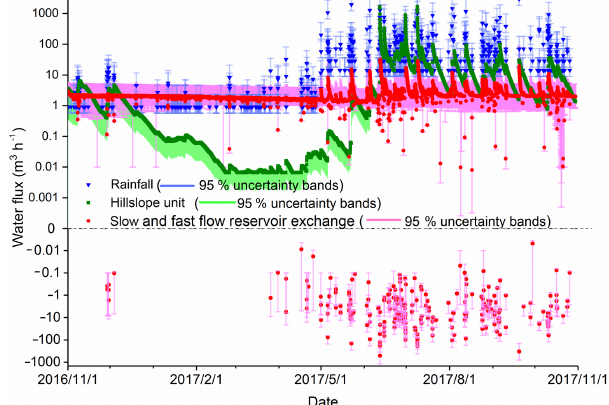
Figure 9. Source contributions to the underground streamflow (fast reservoir) at the catchment outlet (mean of the simulations for the best 500 parameter sets). The red dots above and under the dotted line represent transient reverse water fluxes from the slow reservoir to fast reservoir and fast reservoir to slow reservoir, respectively.